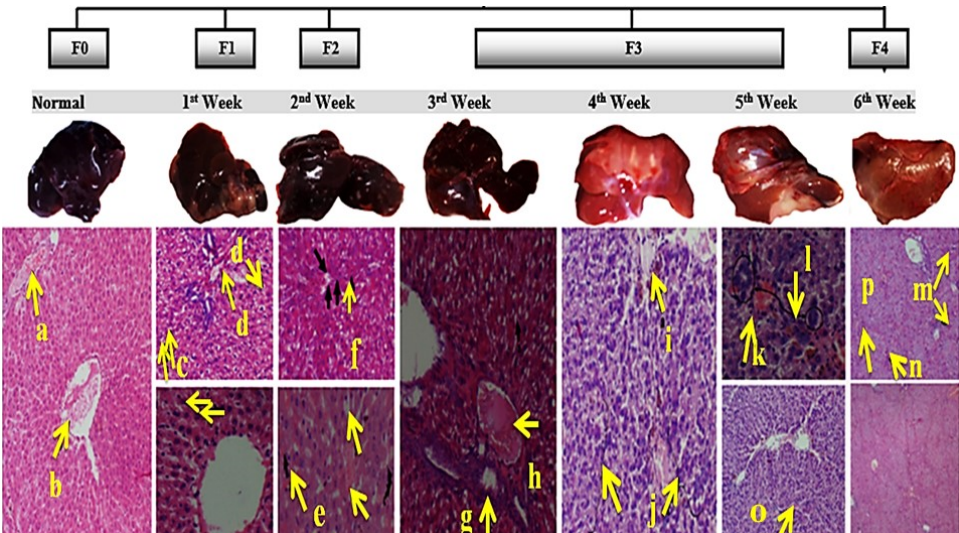
Figure 4. Meta-analysis of histological data in viral hepatitis (METAVIR) staging/classification for fibrosis and per week histopathology of the liver during cirrhosis induction. Normal (a,b), indica- tions of mild fatty liver in first week (c,d), more fatty appearance in second week (e,f), severe fatty deposition in third week (g,h), Cholestasis in fourth week (i,j), and, complete cirrhosis achieved in fifth and sixth week (k,l).